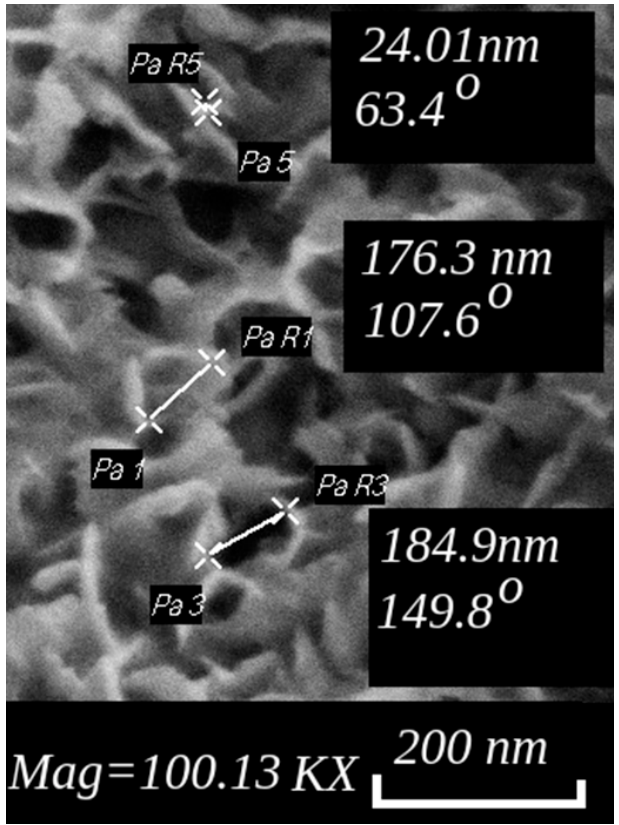
Figure 8. Electronic microphotograph of the surface of steel St3 surface after 60 days exposure with structural elements measurement.